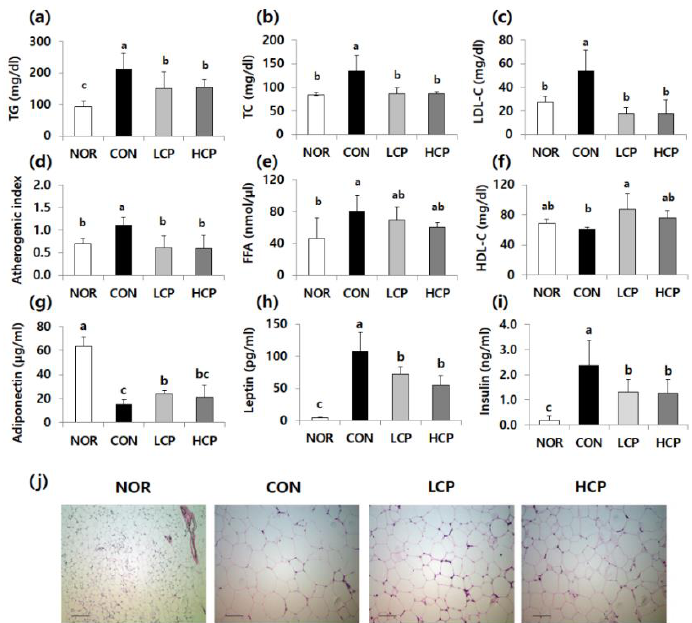
Figure 2. Effects of two skate skin-derived collagen peptides with different molecular weights on plasma lipid ( a – f ), adiponectin ( g ), leptin ( h ), and insulin levels ( i ), and lipid droplets in adipose tissue ( j ). Data are mean ± standard deviation (SD) ( n = 10 per group). Experimental groups were divided into four groups; m/m mice were orally administered water as a vehicle (NOR group) whereas db/db mice were orally administered water (control group, CON), LCP (LCP group), or HCP (HCP group) at a dose of 200 mg·kg bw −1 ·day −1 for 8 weeks. a–c Different letters mean significant differences to one-way analysis of variance (ANOVA), followed by Duncan’s multiple-range test at p < 0.05. The atherogenic index (AI) was calculated as (TC - HDL-C) / HDL-C. Histological analysis of adipose tissue was performed using hematoxylin and eosin staining, magnification: 200×, bar: 50 μm.